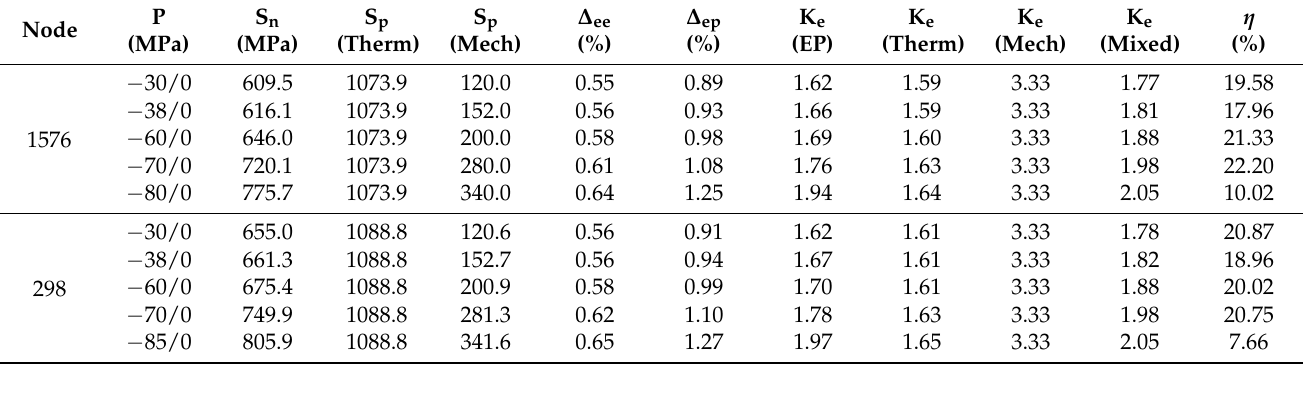
Table 4. Results of K e under thermal ( ∆ T = 280 ◦ C) and pressure load of Z2CND18.12 (nitrogen control) for nozzle model.